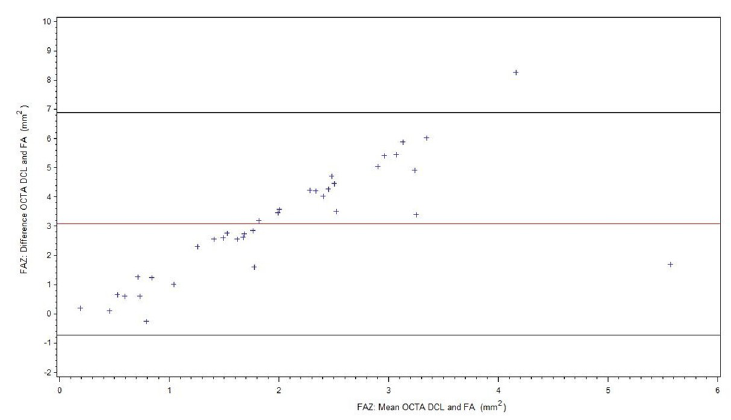
Fig 8. FAZ: Bland-Altman-Plot for the agreement of FA and OCTA DCL in patients with ME.